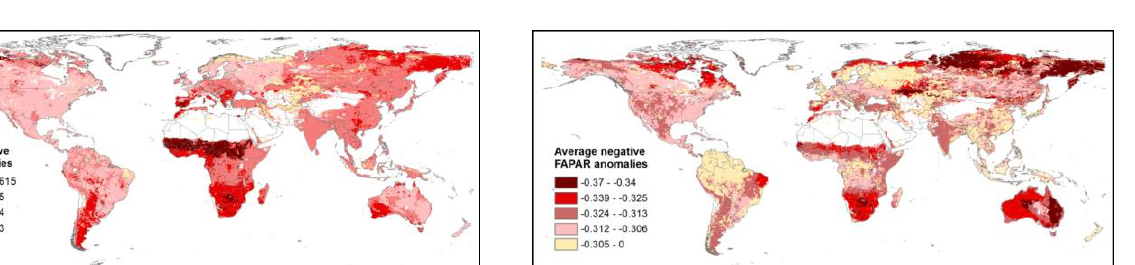
Figure 5. SPEI12 ( left ) and FPAR3g ( right ) anomalies between 1982 and 2011 averaged within the